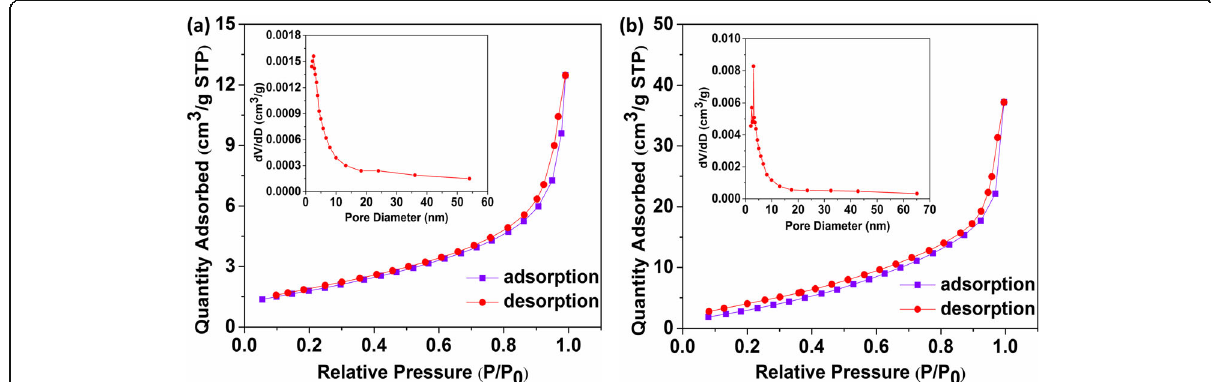
Fig. 6 Nitrogen adsorption – desorption isotherms curves of pure In 2 O 3 ( a ) and 5%Ag-In 2 O 3 ( b ) samples. Insets are the corresponding pore size distribution curves obtained by the BJH method